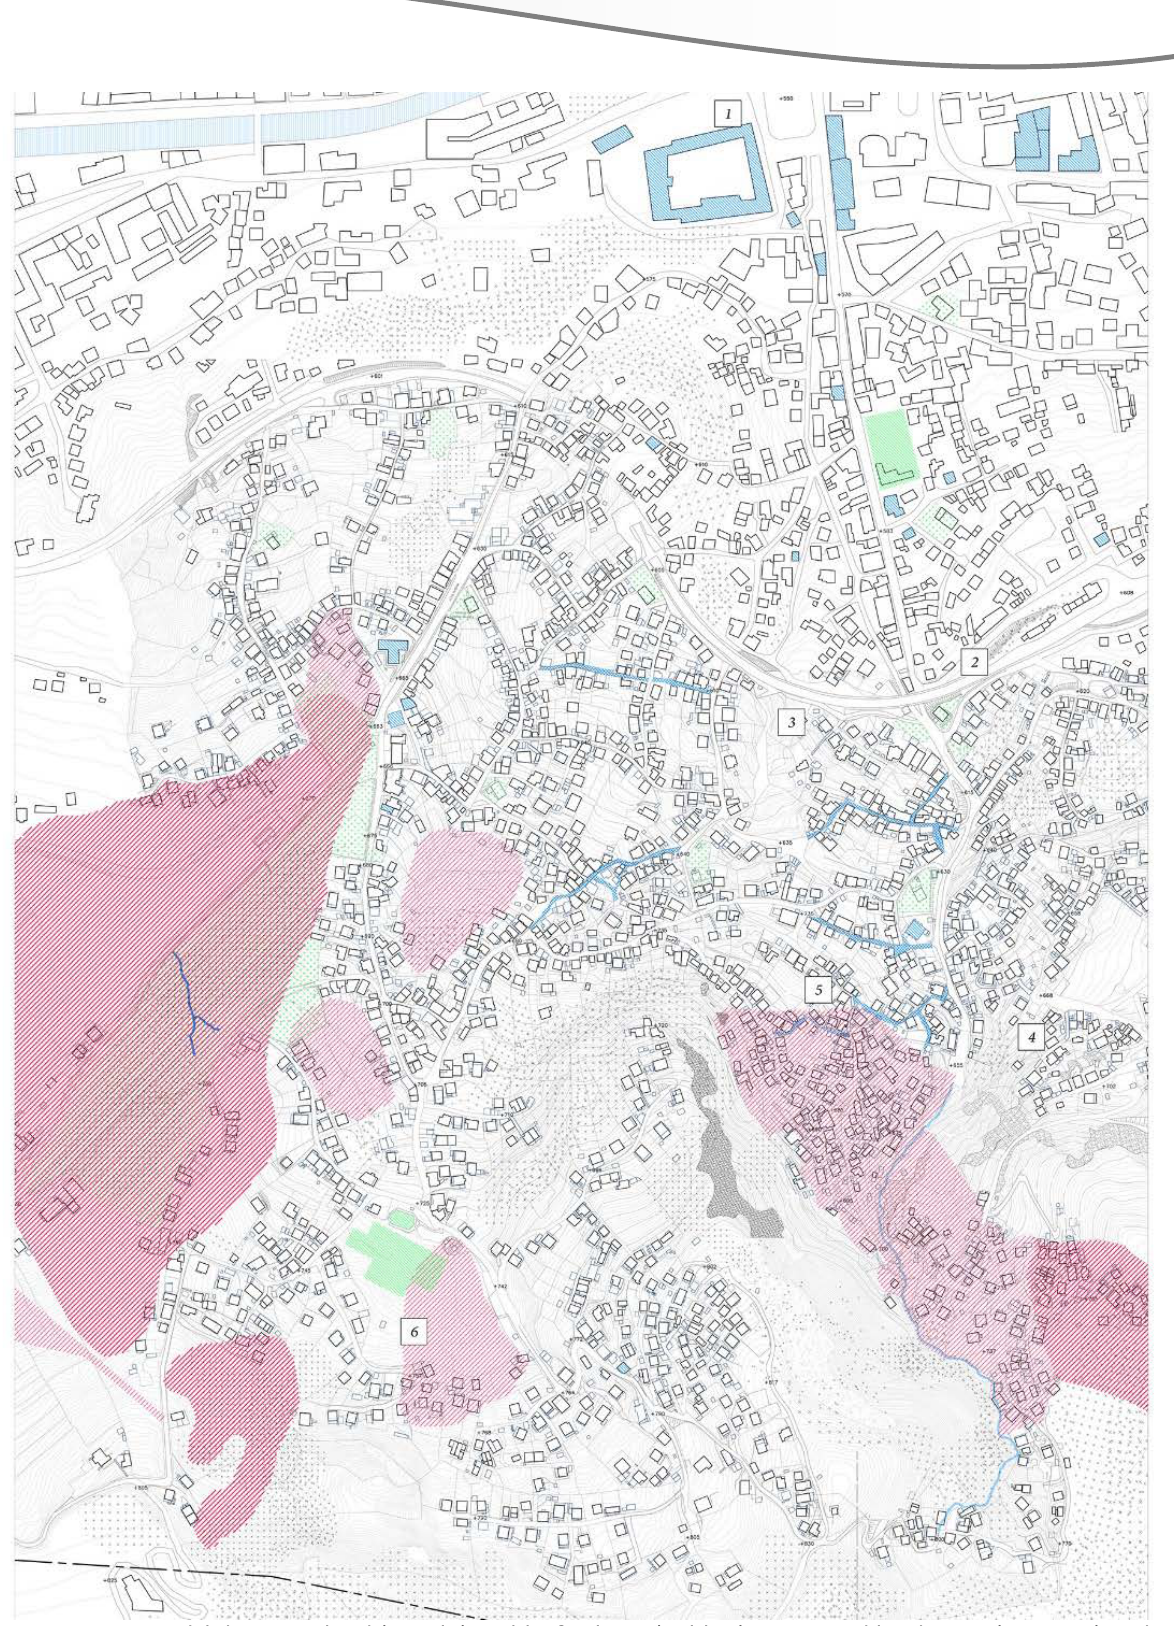
Figure 11: Landslide prone land (purple), public facilities (in blue), protected landscape (in green) and roads subject to future improvement (in blue) in Širokača. The numbers refer to design elements which were studied in